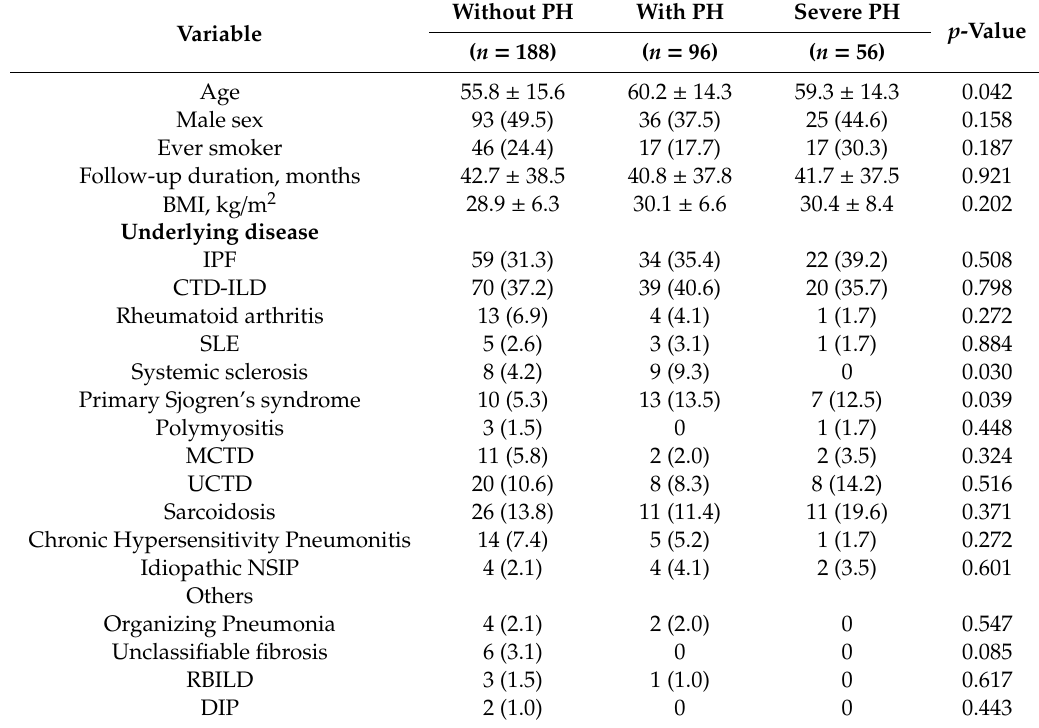
Table 1. Demographic characteristics of the study